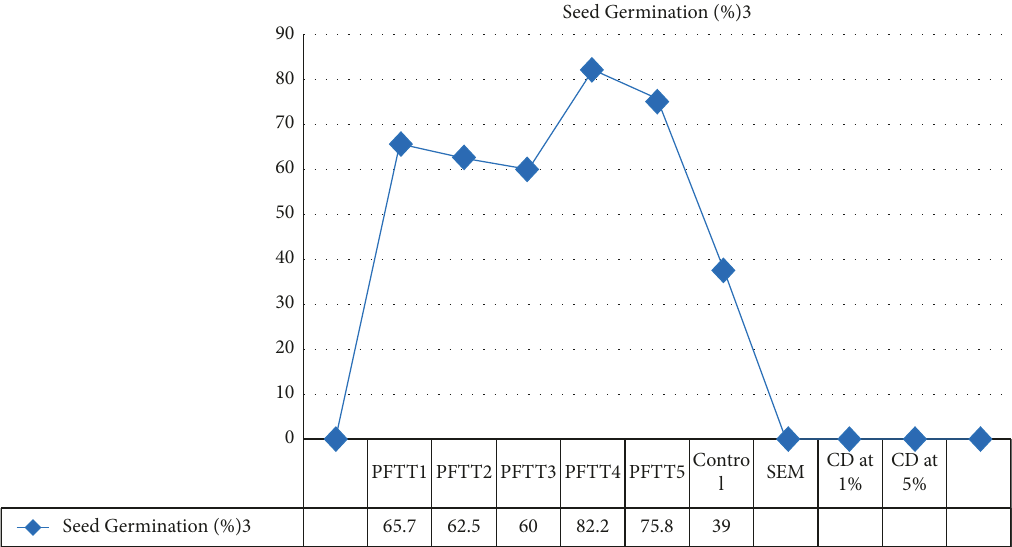
Figure 2: Graph scale of Pseudomonas fluorescens effect on seed germination and vegetative growth of